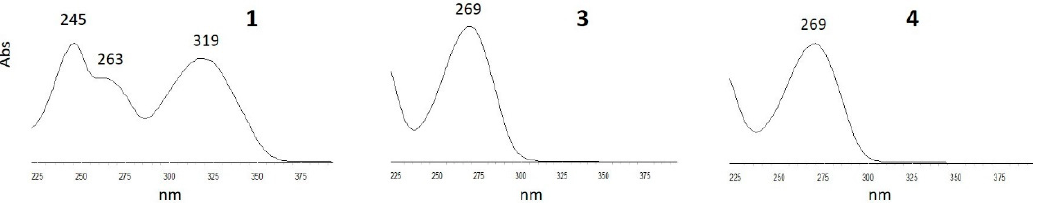
Figure 6. In-line UV-visible spectra (220–400 nm) corresponding to Figure 5: 1 (Rt = 24 min), 3 (Rt = 27 min), and 4 (Rt = 29 min).